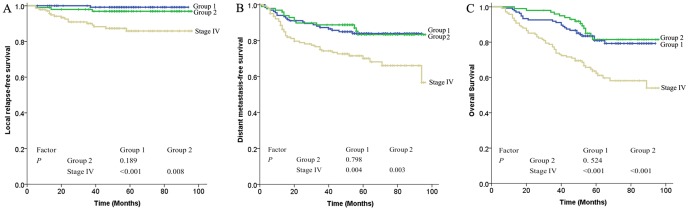
Survival rate by clinical stage in 375 patients: (A) local relapse-free survival, (B) distant metastasis-free survival, and (C) overall survival.Group 1: Stage III without MRI-detected cranial nerve involvement; Group 2: Stage III with MRI-detected cranial nerve involvement.